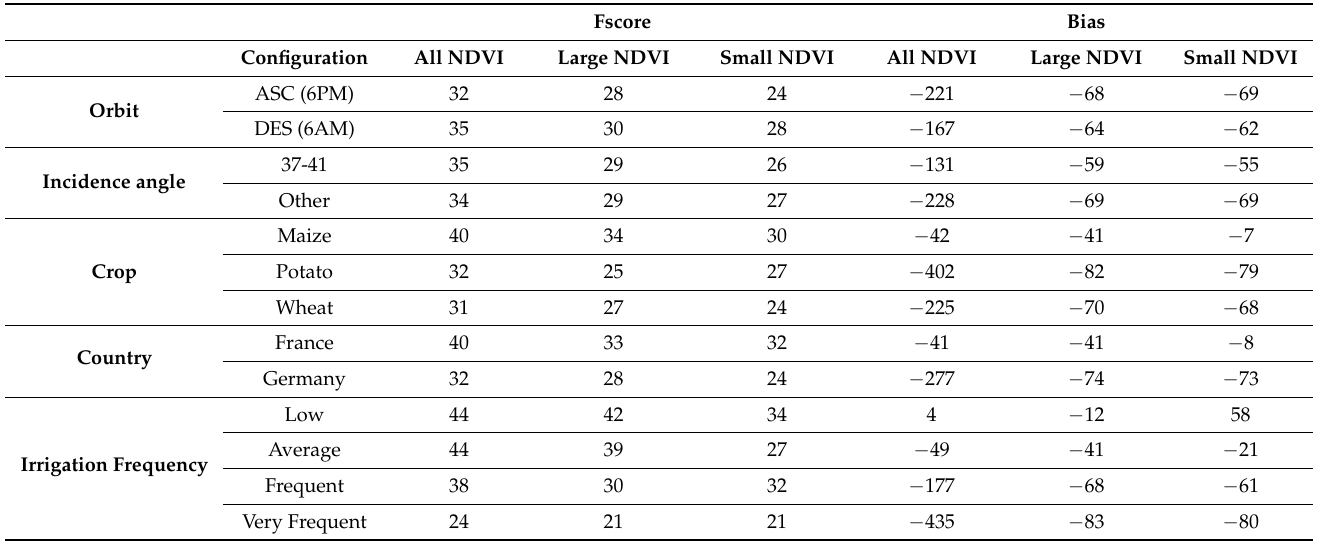
Table 2. Scores (F-score, bias) of the bucket approach according to different configurations (orbit, incidence angle, crop, country, irrigation frequency), and the level of NDVI (all data, small NDVI values, high NDVI